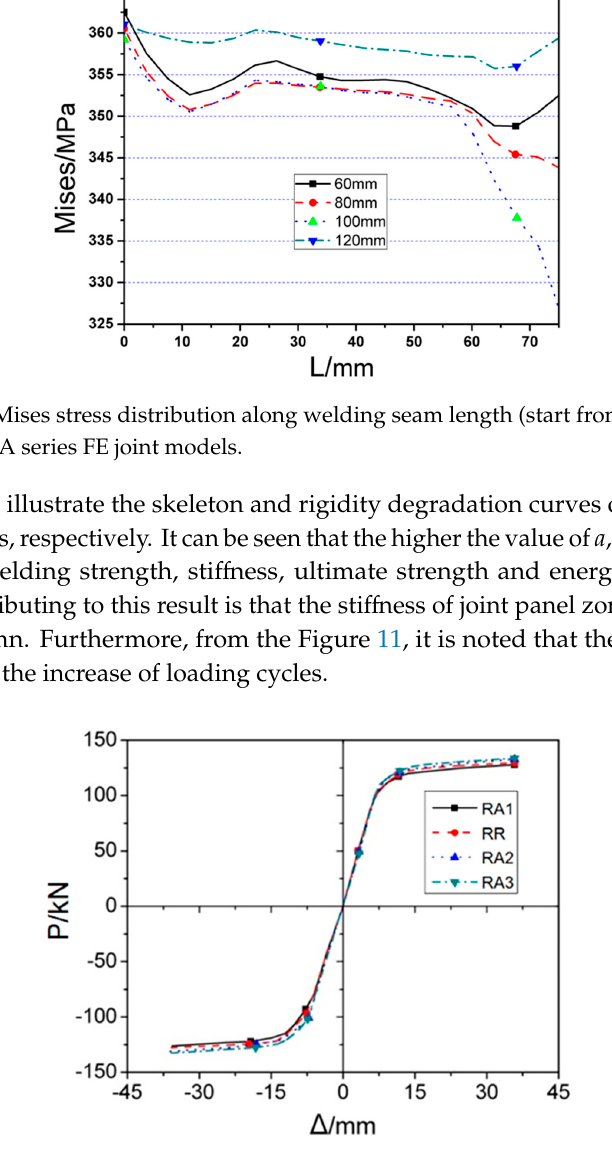
Figure 10. The skeleton curves of RA series FE models under cyclic loading.